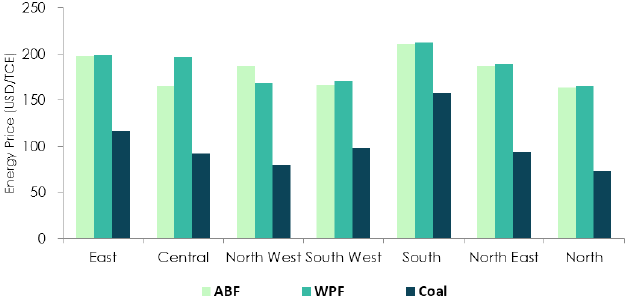
Figure 9. Energy cost of BMF and coal in China’s